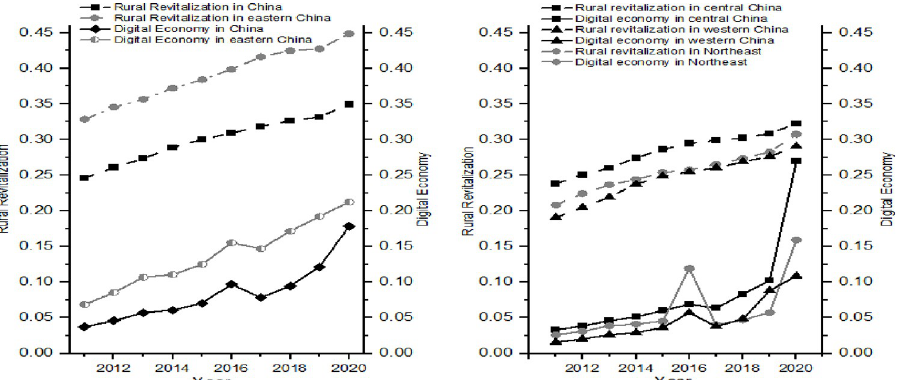
Fig 2. Trends of the digital economy and rural